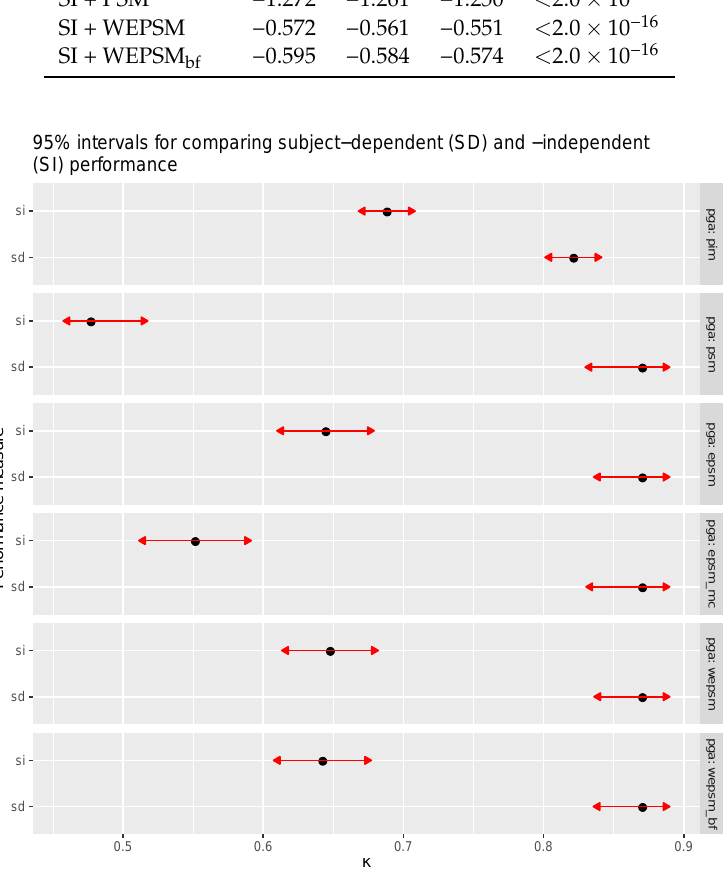
Figure 7. Estimated marginal means for the (average) difference between subject-dependent (SD) and subject-independent (SI) performance across personalisation–generalisation